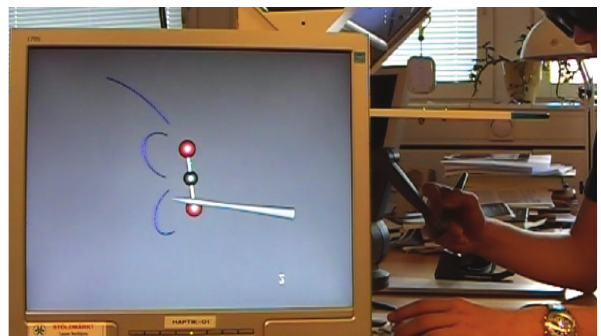
Figure 3: Video screenshot from the think-aloud session with S1. A CO 2 molecule surrounded by three field lines (blue) is shown. S1 probes a recently introduced field line using the haptic device (right hand). Also shown are the stereoglasses (top right) and the 3D mouse (left hand) that the student uses to manipulate the molecule during interaction within the virtual